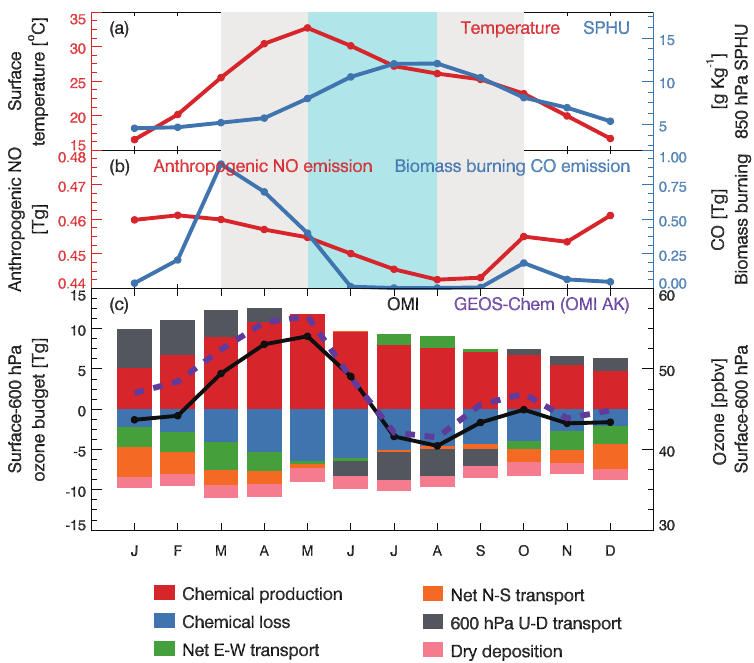
Figure 2. Monthly mean (averaged for 2006–2010) (a) surface temperature (red) and 850hPa averaged specific humidity (SPHU, blue); (b) anthropogenic NO emissions (red) and biomass burning CO emissions (blue); and (c) lower tropospheric ozone (averaged for surface to 600hPa, in unit of ppbv) from OMI satellite observations (black) and GEOS-Chem model simulations with OMI averaging kernel matrices and a priori profiles applied (dashed purple). The shading in (a, b) represents pre-summer, summer, and post-summer South Asian monsoon periods. Colored bars in (c) show processes that affect lower tropospheric ozone budget over the Indian land diagnosed in GEOS-Chem simulations. Upward (U) and downward (D) vertical transport fluxes are calculated at 600hPa. Horizontal transport from west (W) to east (E) and from south (S) to north (N), and downward vertical transport are defined as positive